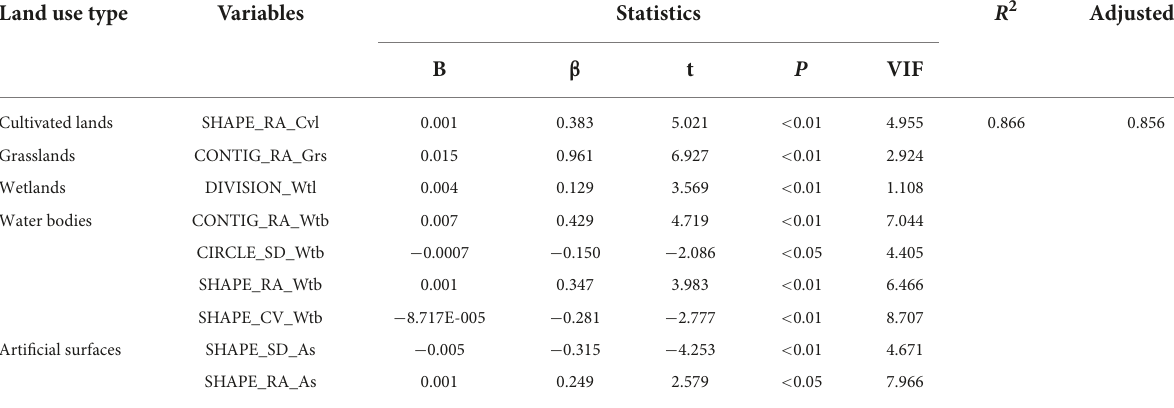
TABLE 8 Multiple regression analysis results obtained for the leading landscape patterns at the city scale. Land use